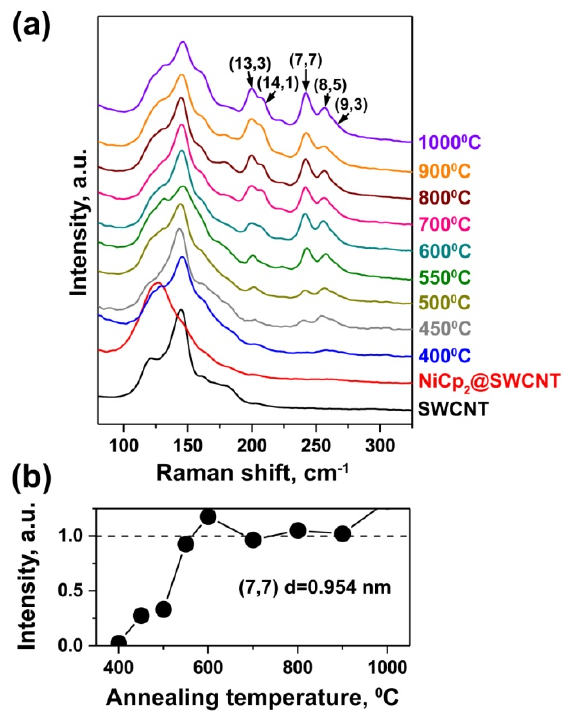
Figure 3. ( a ) The RBM-band of Raman spectra of SWCNTs, nickelocene-filled SWCNTs and samples annealed at temperatures between 400 and 1000 °C for 2 h. The chiral vectors of inner nanotubes are denoted. ( b ) The dependence of normalized intensity of the peak of inner tube with chirality of (7,7) on annealing temperature.